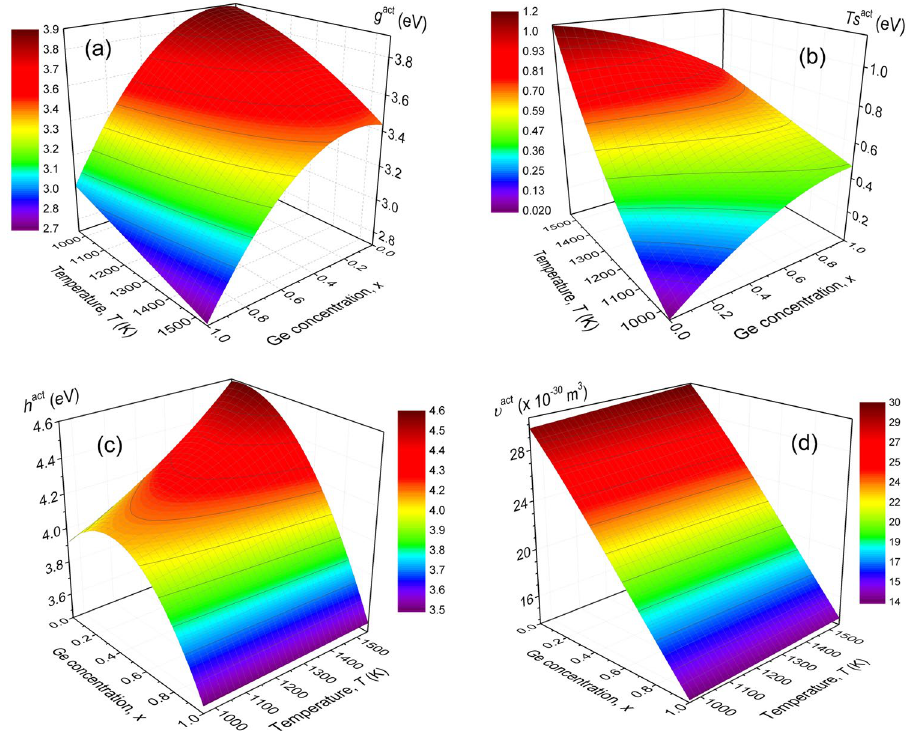
Figure 4. 3D surface plots of the point defects thermodynamic parameters for Ge self-diffusion in Si 1 − x Ge x alloys, as a function of temperature (963–1543 K) and Ge concentration, x , according to the cBΩ model. ( a ) Activation Gibbs free energy, g Geact , ( b ) the energy term Ts Geact , ( c ) activation enthalpy, h Geact and ( d ) activation volume, υ Geact